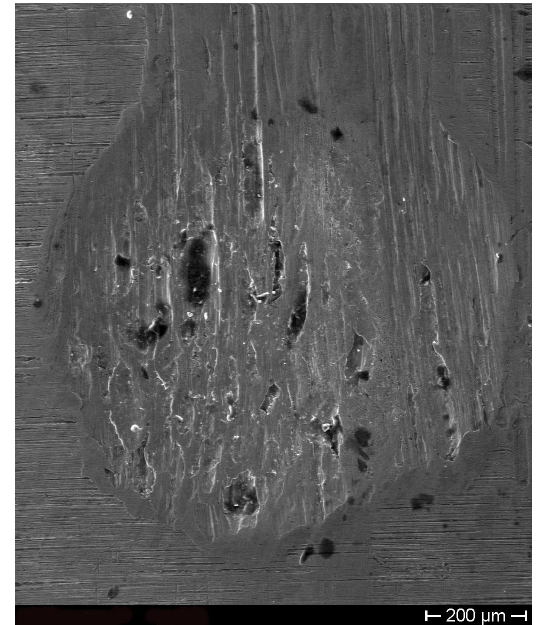
Figure 9: SEM micrograph of a circular impression found in the central part of the piston (sample 1).